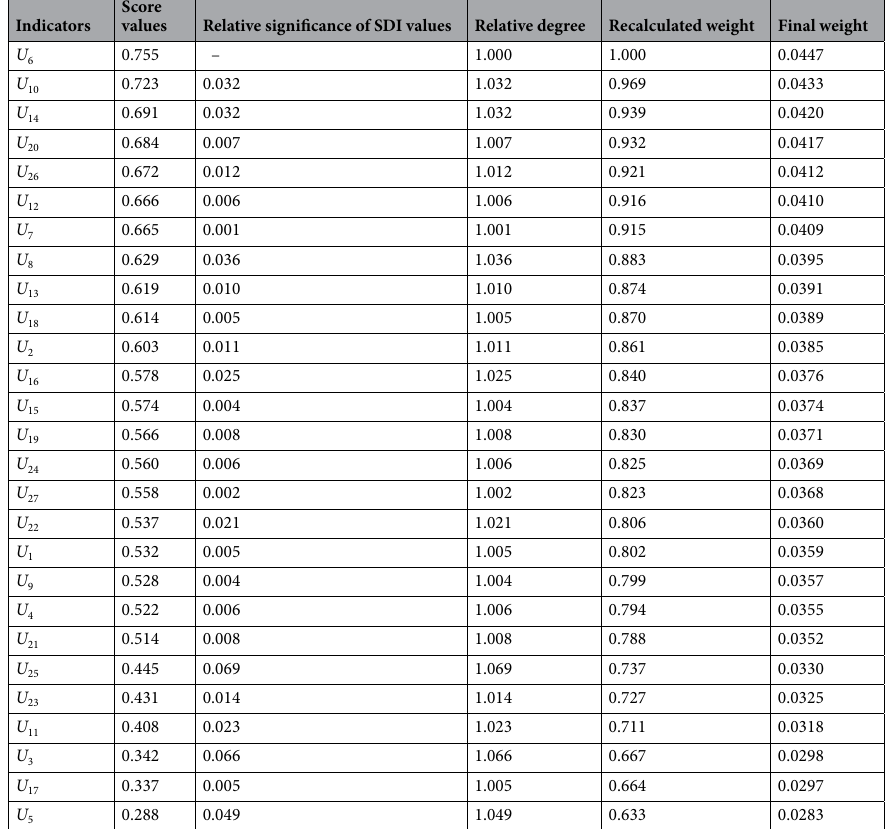
Table 10. Subjective weights for SDIs using the SWARA method.